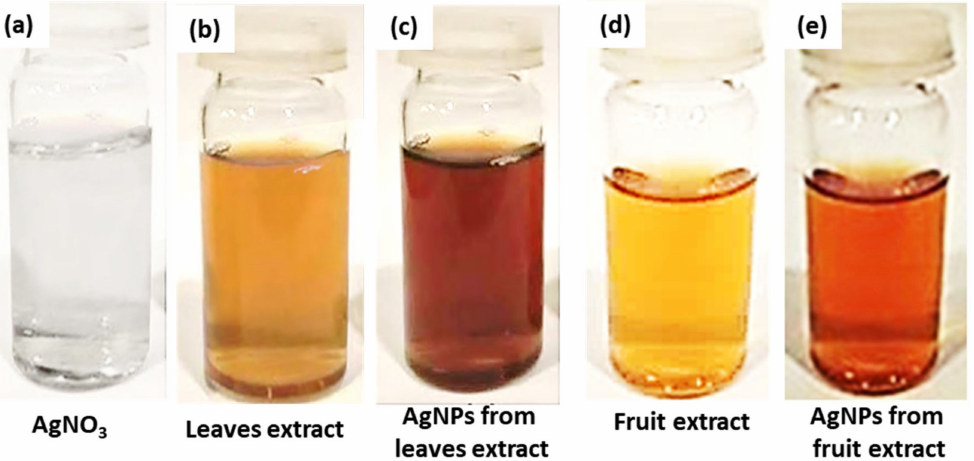
Figure 2. Schematic of silver nanoparticles preparation ( a ) AgNO 3 solution, ( b ) Annona squamosa leaf extract, ( c ) AgNPs from leaf extract, ( d ) Annona squamosa fruit extract, and ( e ) AgNPs from fruit